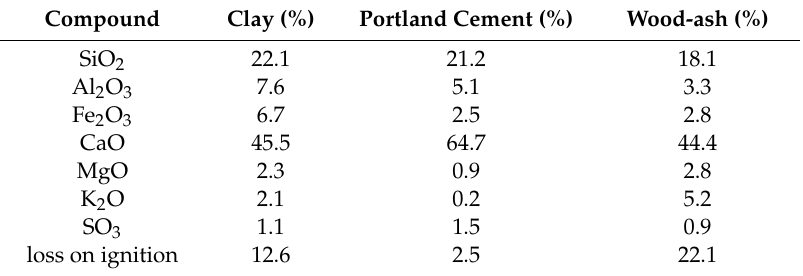
Table 2. Chemical analysis of the clay, Portland cement, and wood-ash. Compound Clay (%) Portland Cement